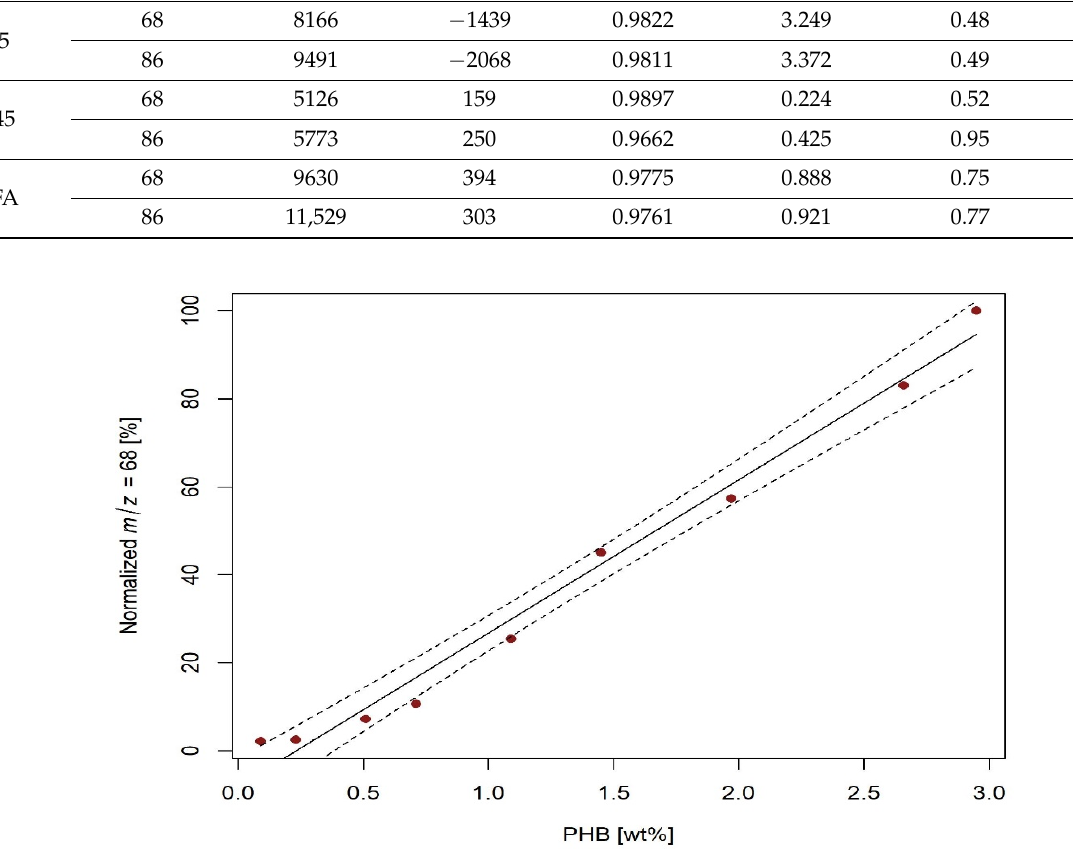
Table 2. Parameters of calibration lines for the determination of PHB micro-bioplastics in standard LUFA soil and two real soils by detection of degradation gas products with m / z 68 and 86. Table 3. Parameters of calibration lines for the determination of PLA micro-bioplastics in standard LUFA soil and two real soils by detection of degradation gas products with m / z 29 and 43.